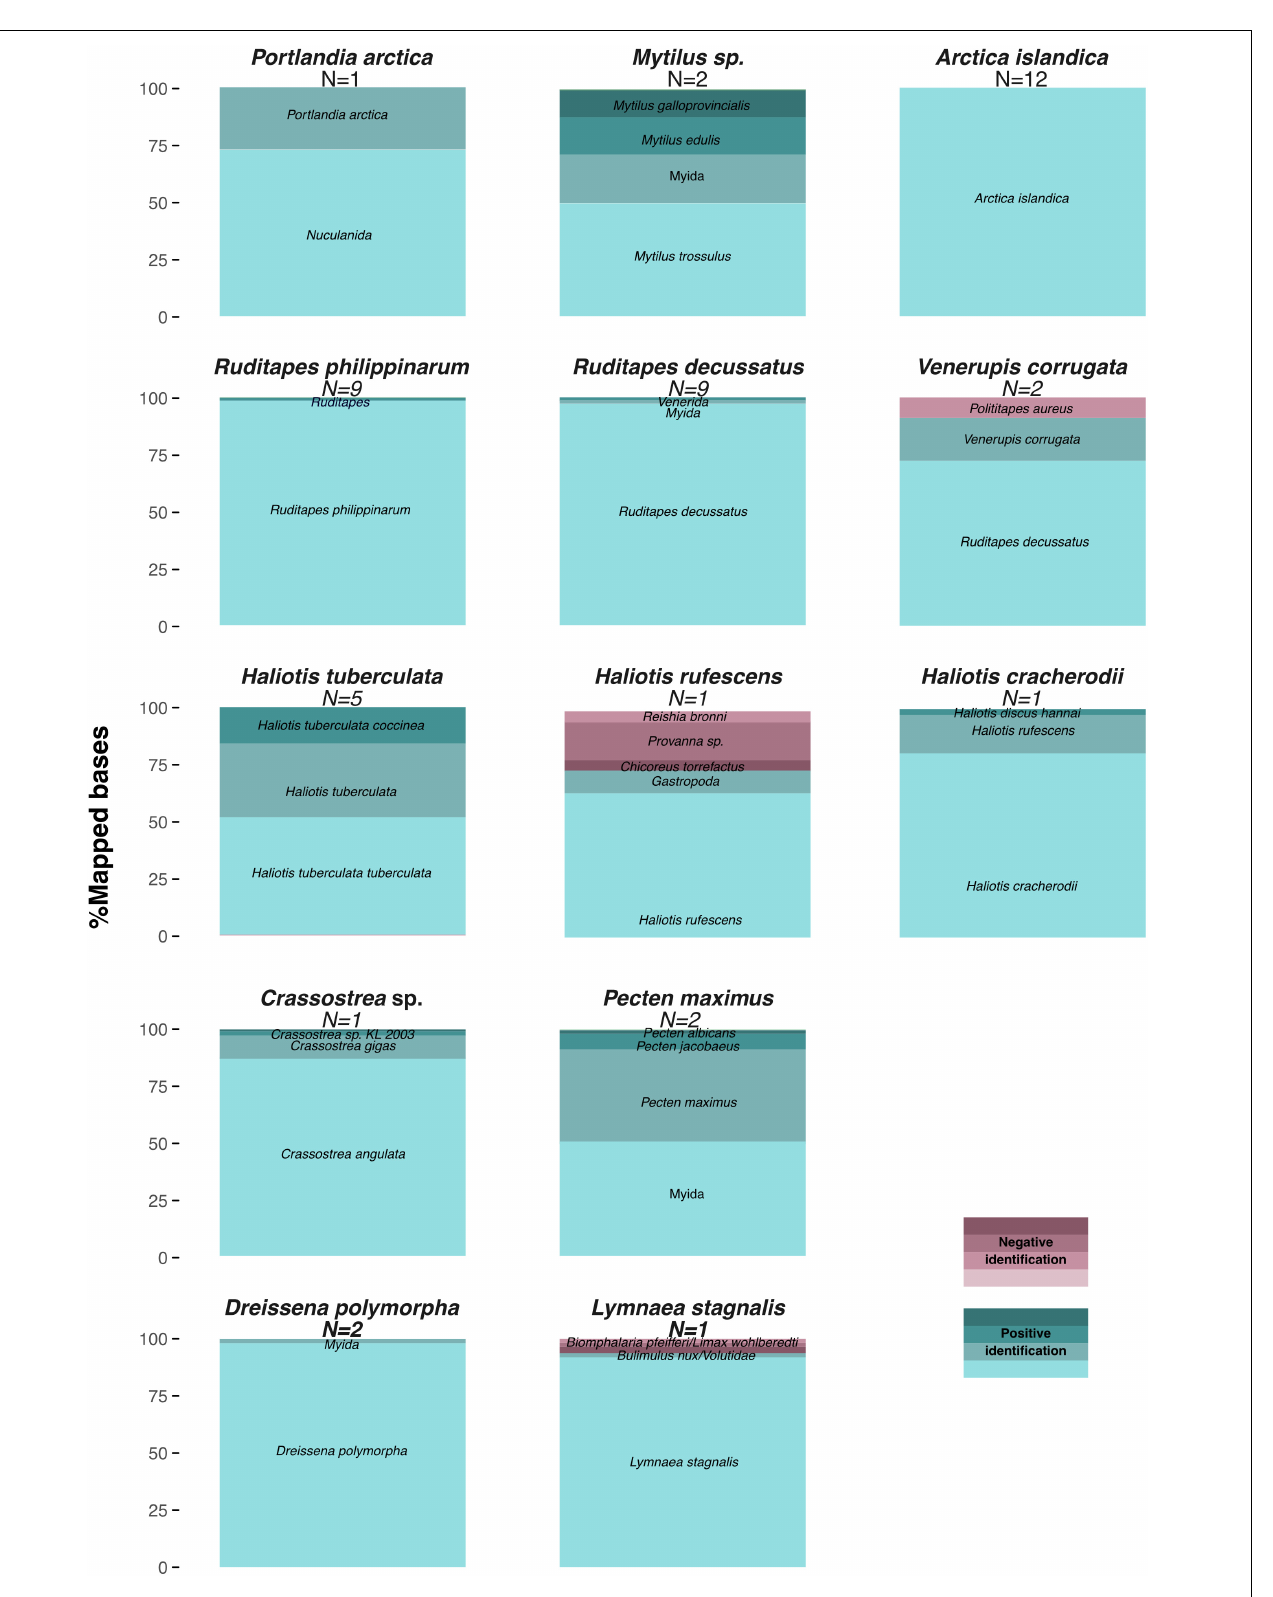
Frontiers in Ecology and Evolution |